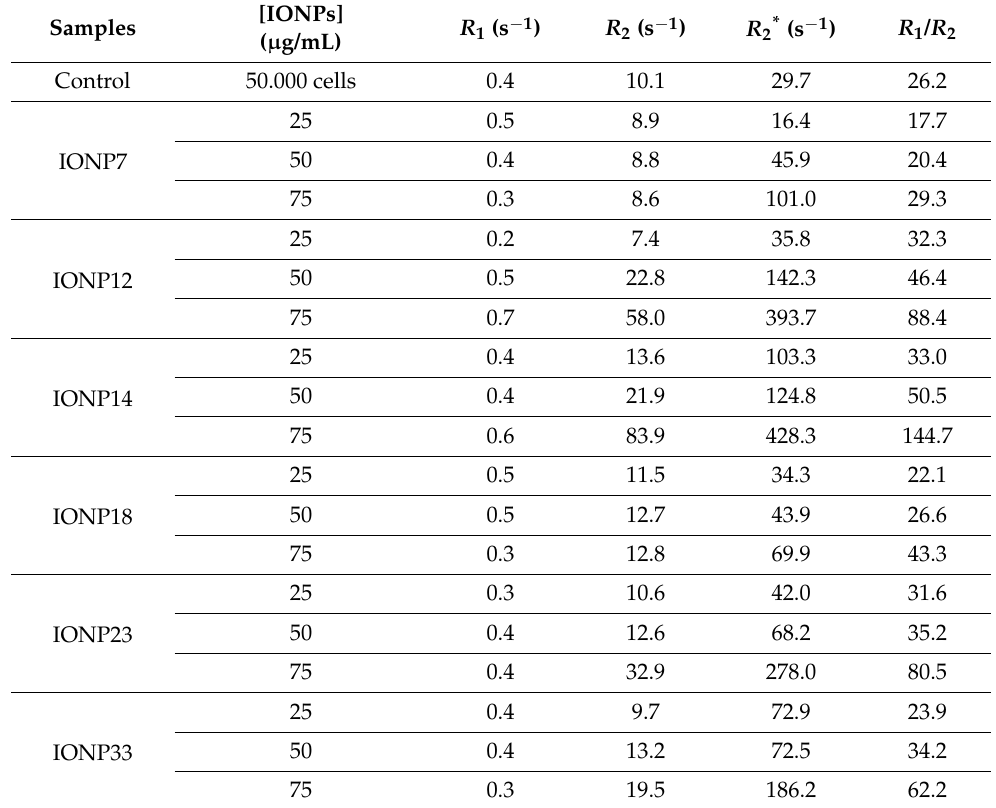
Table 2. Relaxation rate values, R 1 , R 2 , and R 2* and coefficient R 2 / R 1 values from MRI at different IONPs initial concentrations of 25, 50 and 75 µ